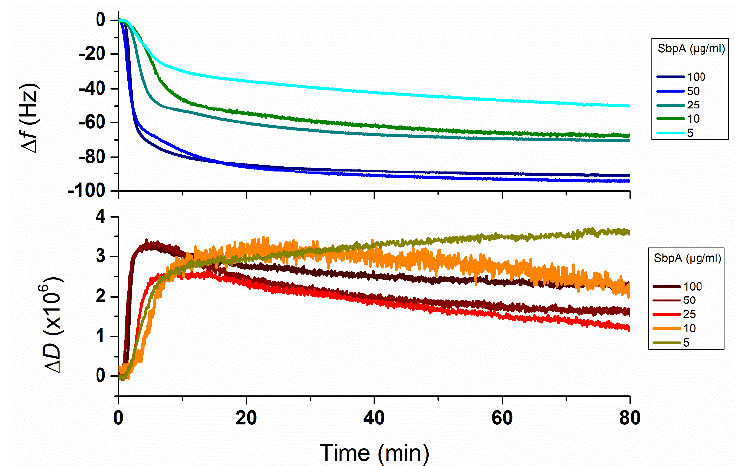
Figure 1. Representative Quartz Crystal Microbalance with Dissipation (QCMD) experiments monitoring the in situ frequency (top) and dissipation (bottom) factor time evolution. Each color corresponds to the respective SbpA concentrations (in µ g/mL) supplied by continuous feeding (25 µ L/min). A closer look over the initial slopes of the frequency vs. time values also permitted quantifying the concentration-dependent kinetics of the protein-surface interaction, based on the ease to diffuse and attach to the underlying hydrophobic substrate. The resulting slope values from the representative experiment shown in Figure 1 as well as those from its stopped-flow partner (extracted from Figure S1, see Supplementary Materials ), are collected in Table 1. Table 1. Frequency vs. time slope value variation for different concentrations of SbpA and injection